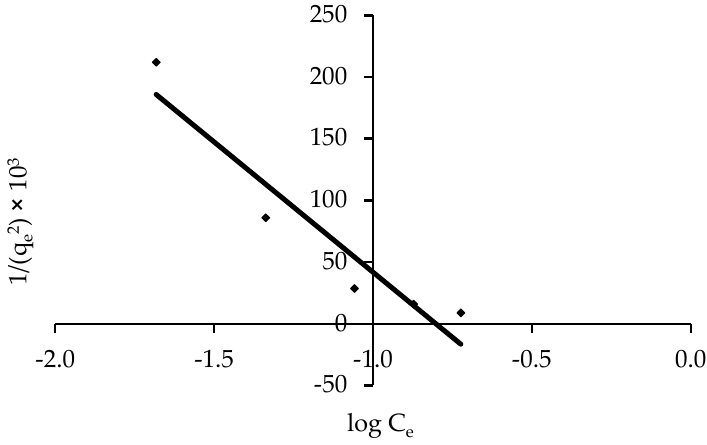
Figure 11. Harkins ‐ Jura isotherm of the removal of IV2R on ZnO ‐